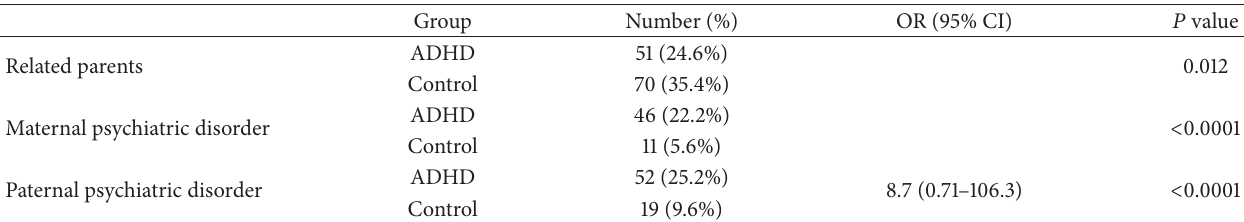
Table 2: Chi-square test for parental psychiatric disorders and their familial relation among case and control